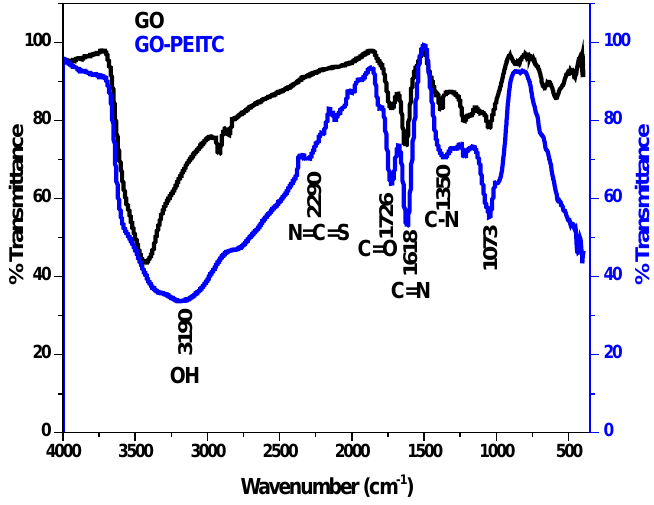
Figure 2. Fourier transformed infrared spectra of GO and the nanocomposite Go-PEITC.